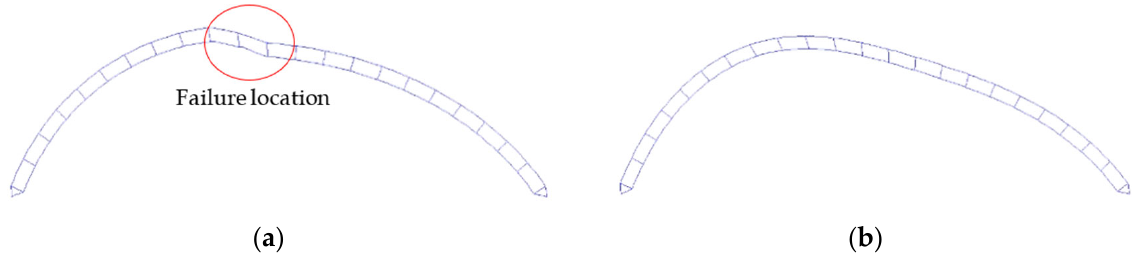
Figure 35. Load–displacement curves of chord and connecting plate failure under HSUVL.